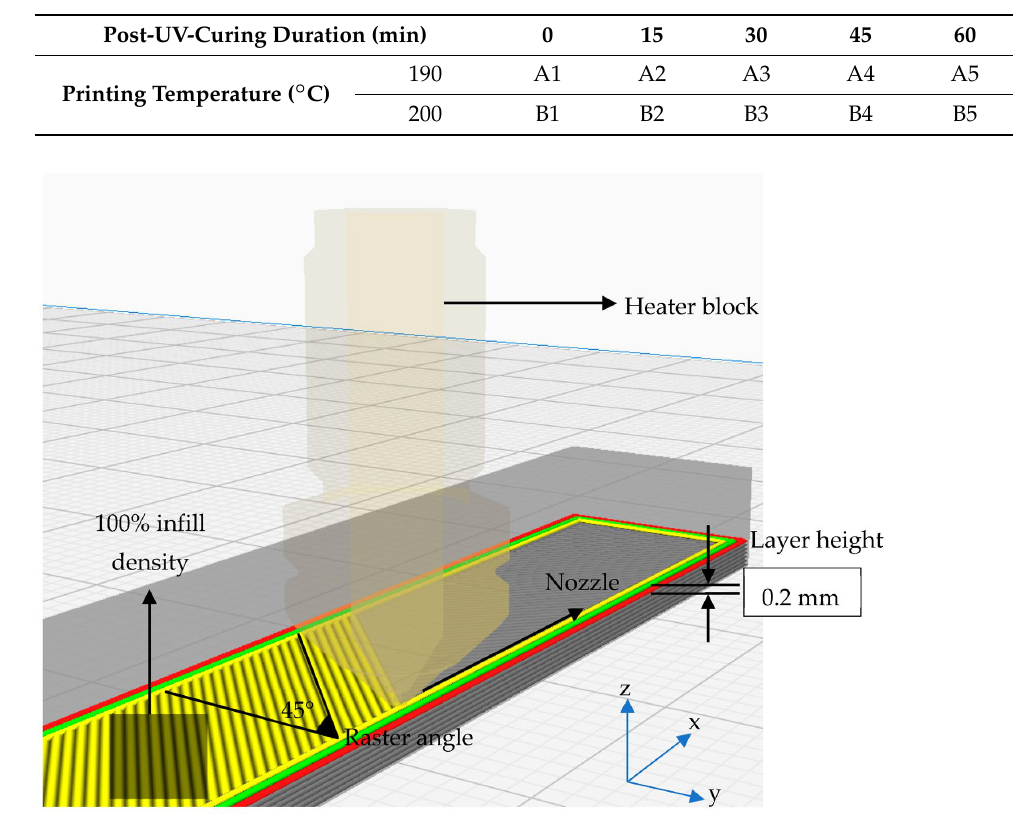
Figure 2. Schematic representation of the production parameters of the three-point bending speci- men.